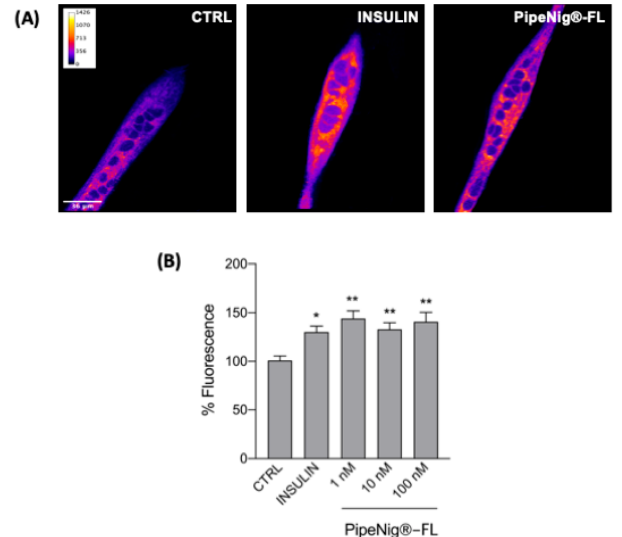
Figure 5. PipeNig ® -FL stimulates glucose uptake. ( A ) Representative confocal images of C2C12